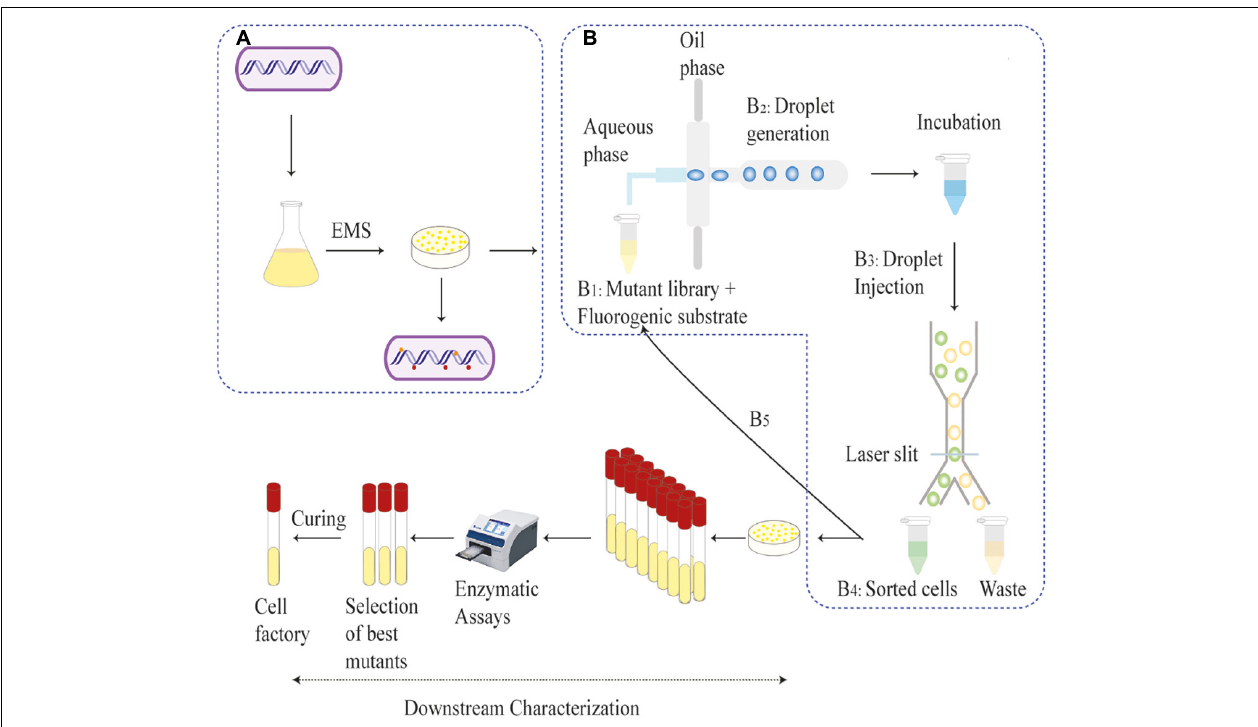
FIGURE 2 | Schematic overview of development and screening of the mutant library: A whole genome mutated library was generated with EMS chemical mutagenesis on shake flask culture and were recovered on an agar as shown in (A) . Steps B 1 –B 5 represents the microfluidic process—The recovered mutants were diluted to 10 7 mutant libraries mixed with fluorogenic substrate (B 1 ) . The droplets generated incubates for the cells to accumulate secretion (B 2 ) . Post incubation, droplets are injected into the sorting chip and sorted based on the fluorescence intensity and collected in an Eppendorf tube. The sorted cells are then released and injected into the device for a second round of droplet generation and screening (B 5 ) . The sorted cells are then released and cultivated on agar plates. The outgrown single colonies are picked for downstream characterization, e.g., shake flask fermentation and protein secretion